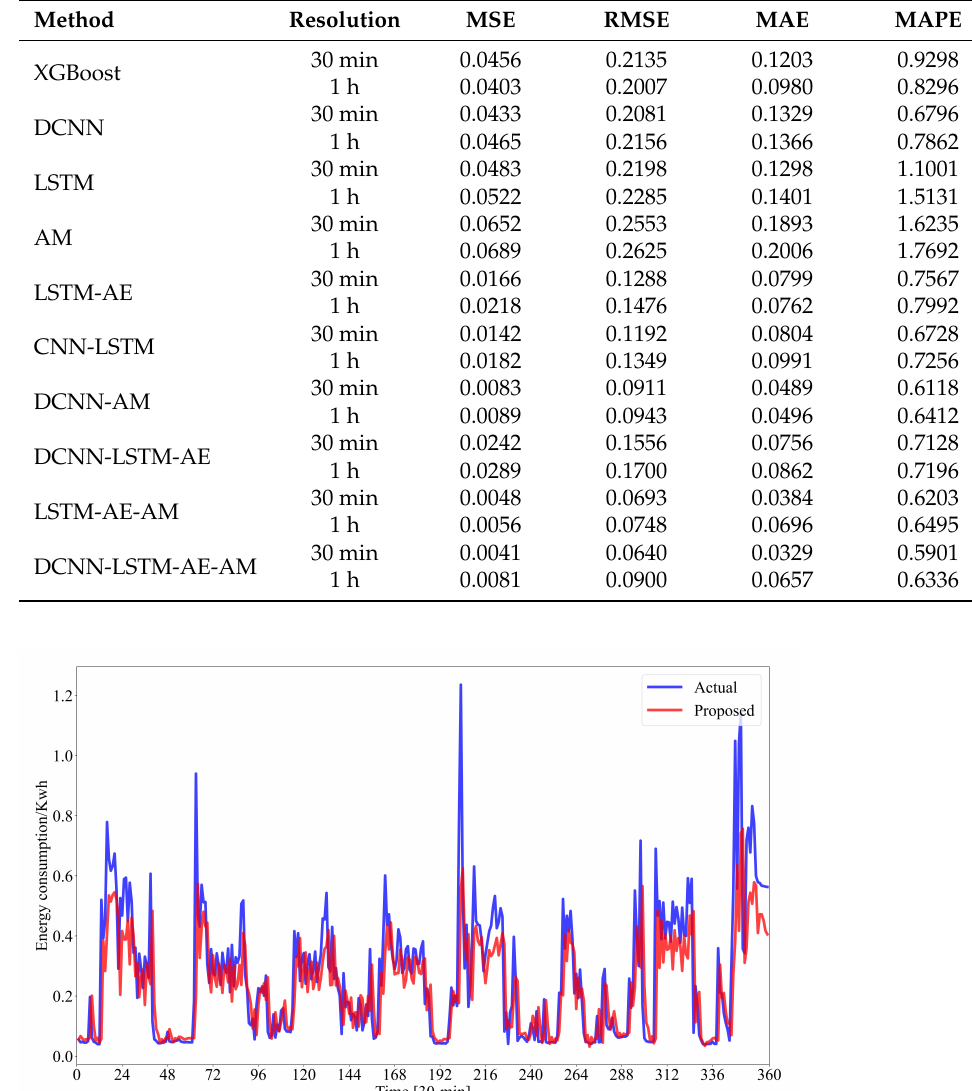
Table 5. Prediction performance comparisons on the SGSC dataset.